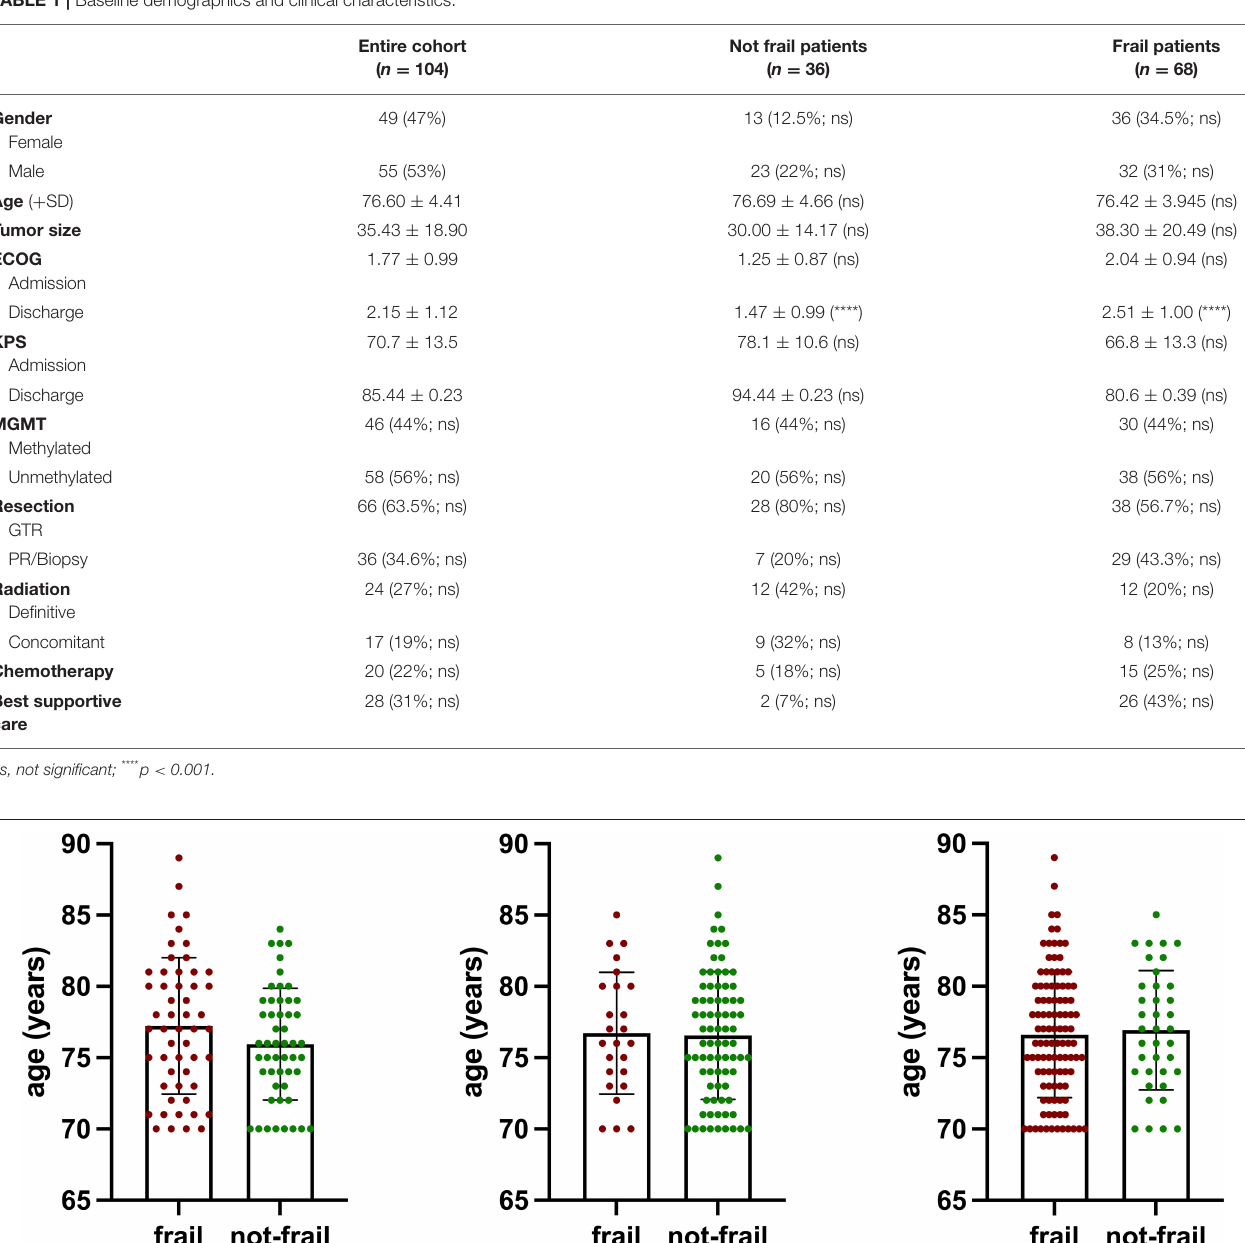
TABLE 1 | Baseline demographics and clinical characteristics.